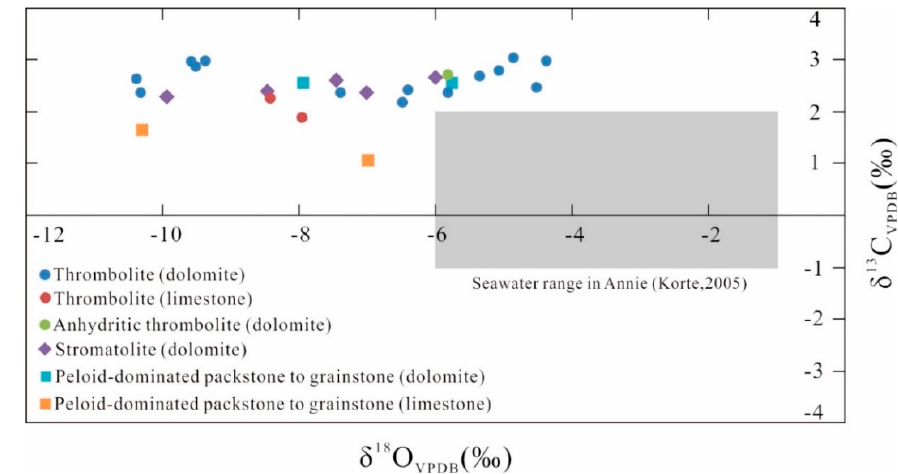
Figure 9. Carbon and oxygen isotopic compositions of different lithofacies in the Leikoupo Formation. VPDB = Vienna Peedee Belemnite.